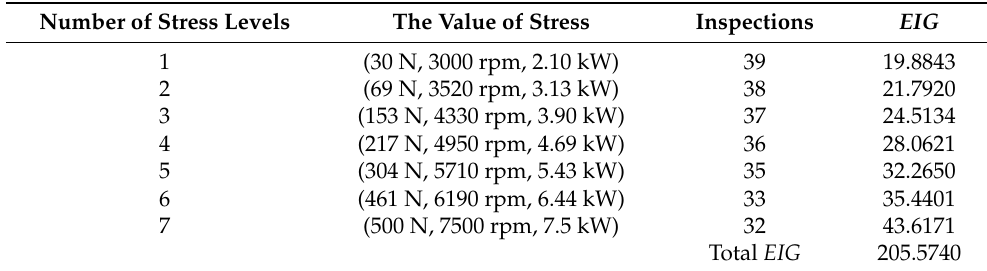
Table 9. EIG obtained for each stress level in the n = 5 optimal test